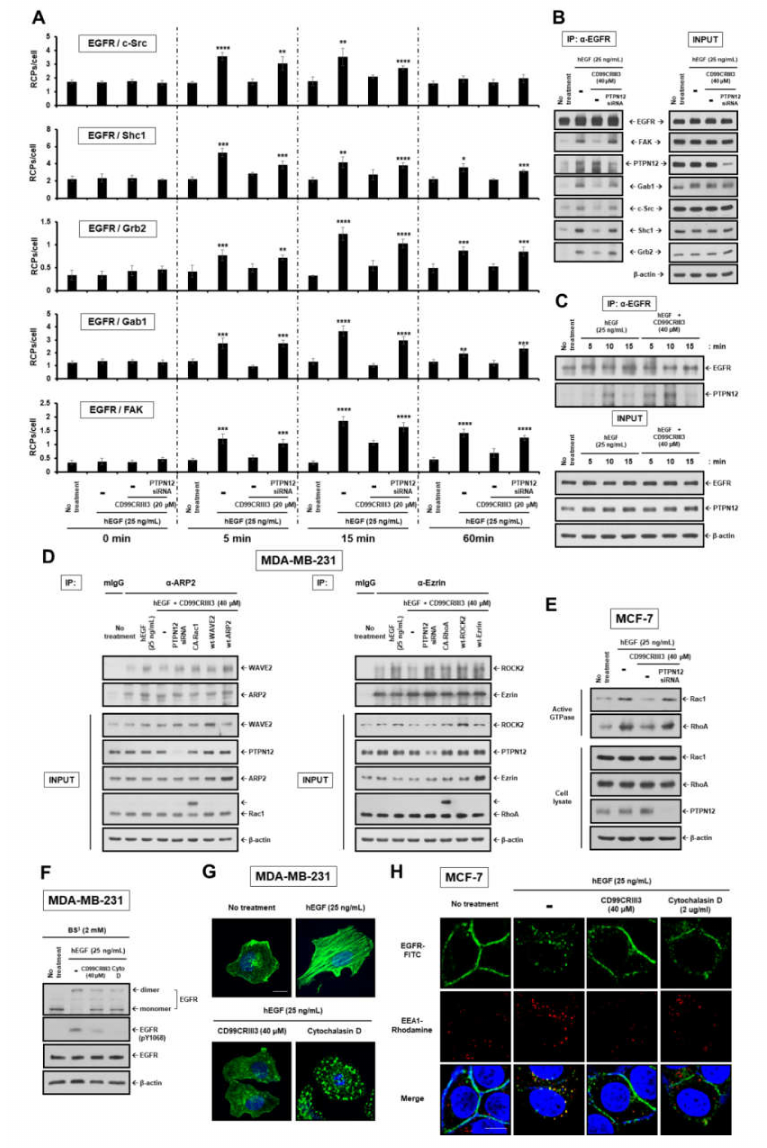
Figure 6. CD99CRIII3 activates PTPN12 to facilitate inhibition of EGFR signaling. ( A ) In situ PLA performed to assess the interactions between the pairs of molecules indicated in MCF-7 cells. * p < 0.05; ** p < 0.01; *** p < 0.001; **** p < 0.0001. ( B ) MDA-MB-231 cells were transfected with PTPN12 siRNA, followed by treatment with EGF (25 ng / mL) with or without CD99CRIII3 (40 µ M) for 15 min. ( C ) MDA-MB-231 cells were treated with EGF and / or CD99CRIII3 in a time-dependent manner. ( D ) MDA-MB-231 cells were transiently transfected with PTPN12 siRNA or expression plasmids encoding CA-GTPases or WAVE2, ARP2, ROCK2, and Ezrin. Cell lysates were immunoprecipitated with the antibodies indicated. The immunoprecipitates were analyzed by Western blot with the antibodies indicated. ( E ) The cells stimulated by binding of ligand to its receptor were assayed for activation of small GTPases. β -actin was used as a loading control. ( F ) For dimerization assay, MDA-MB-231 cells were subjected to BS 3 chemical-mediated crosslinking as described above. Cell extracts were assessed by Western blot analysis to determine the dimerization and phosphorylation levels of EGFR. β -actin was used as a loading control. Actin cytoskeleton organization in MDA-MB-231 cells ( G ) and EGFR endocytosis in MCF-7 cells ( H ) were determined by IFA as described above. Original magnification of representative images, 600 × . Scale bars = 10 µ